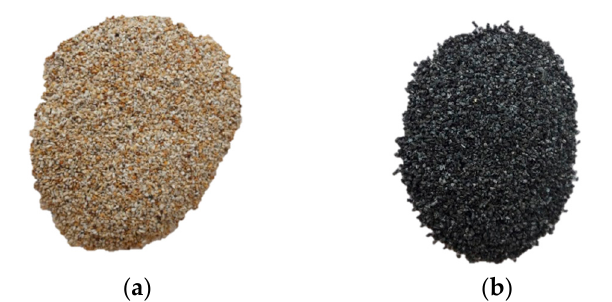
Figure 7. Photographs of ( a ) NZ and ( b ) SZ samples.